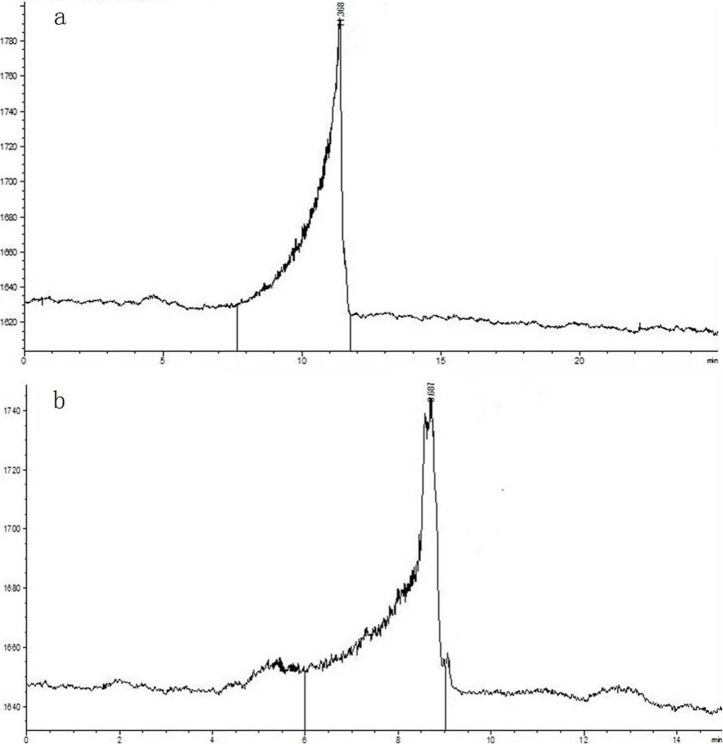
HPGPC chromatograms of MLP-1 (a) and MLP-2 (b).